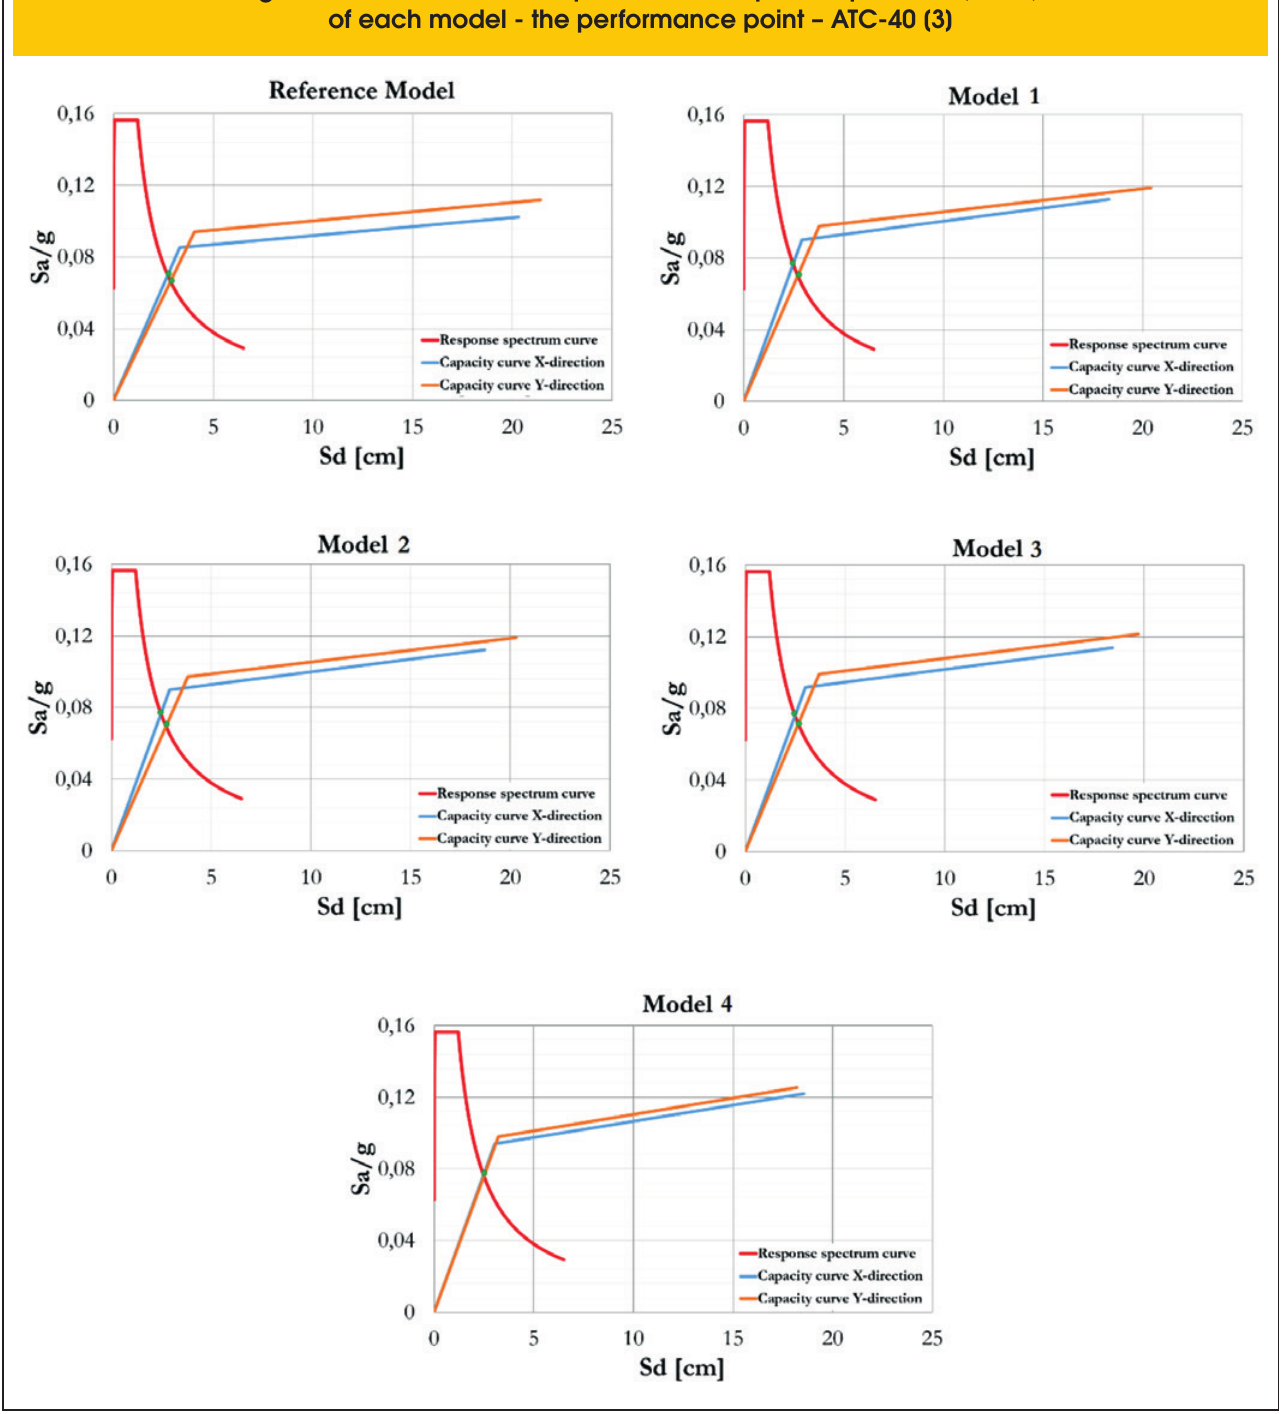
Figure 15 – Acceleration Displacement Response Spectrum (ADRS) of each model - the performance point – ATC-40